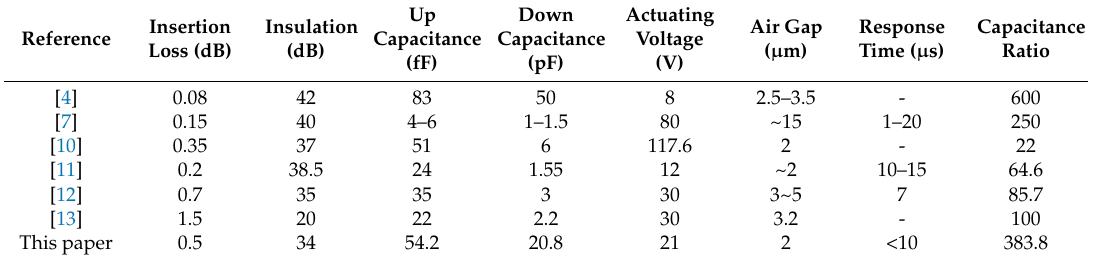
Table 1. Performance comparisons of the proposed high-capacitance-ratio MEMS with generic designs.